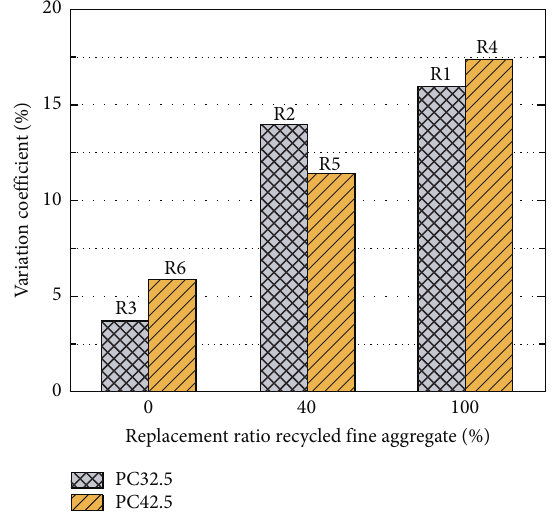
Figure 7: Effect of replacement ratio for recycled fine aggregate on variation coefficient. Table 5: Combination of RCB masonry.